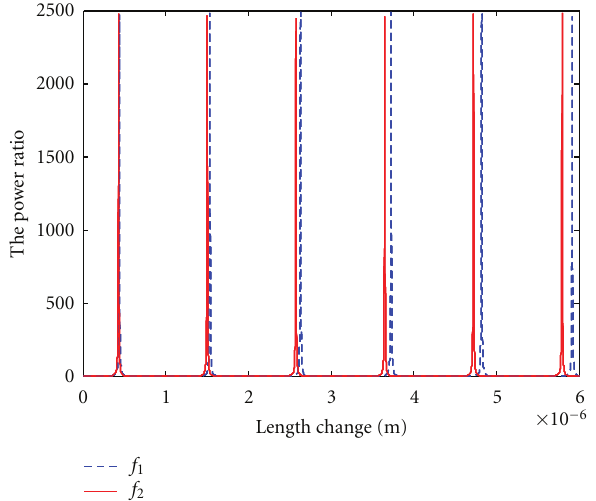
Figure 5: The power ratio for the two optical carriers f 1 and f 2 as a function of the ring resonator length.